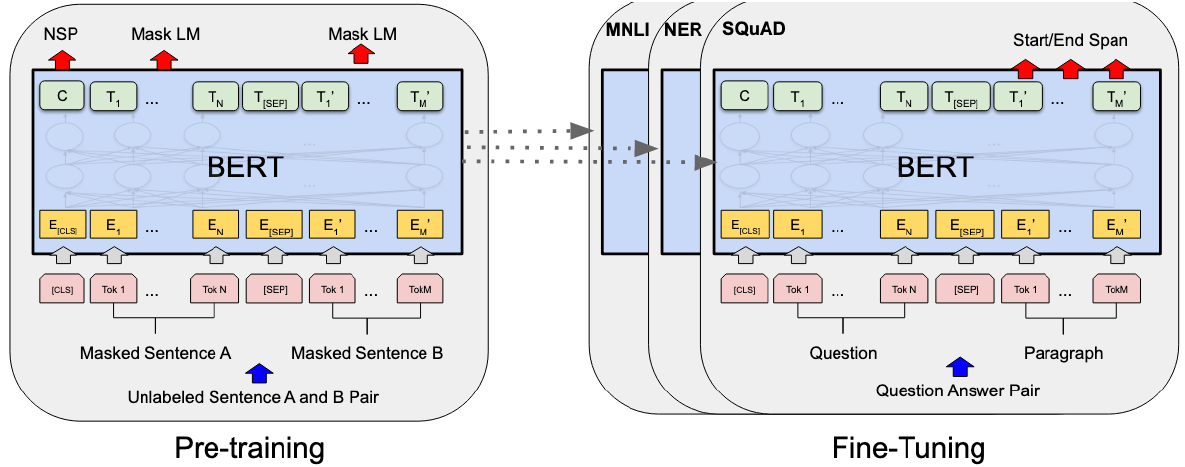
Figure 4. Architecture of the BERT pre‑training and fine‑tuning procedures [12].